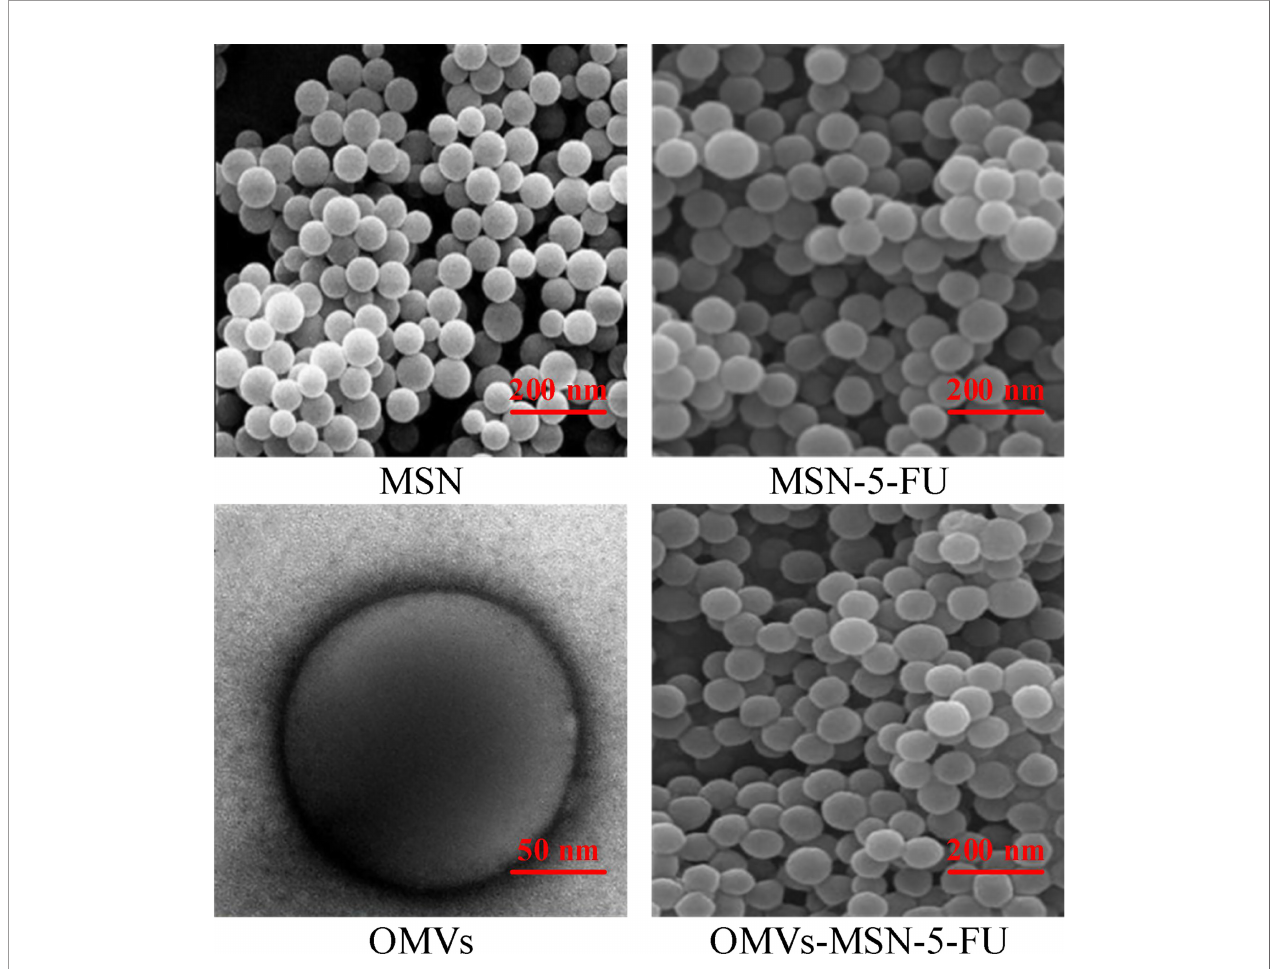
FIGURE 3 | Scanning electron microscope